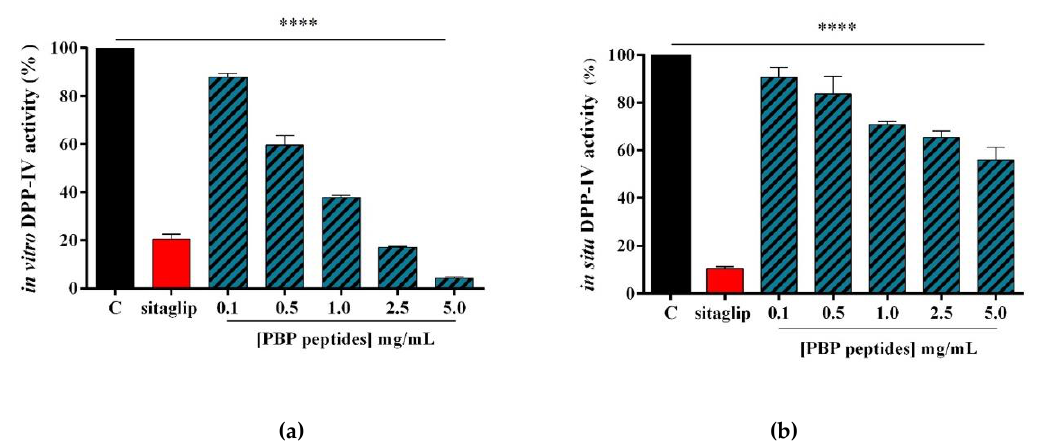
Figure 2. Evaluation of the inhibitory activity of the tryptic PBP hydrolysate on DPP-IV: ( a ) the in vitro inhibition of the activity of human recombinant DPP-IV; ( b ) the in situ inhibition of the DPP-IV activity expressed by non-differentiated Caco-2 cells, after 30 min of treatment. The data are represented as the means ± SD of six independent experiments, performed in triplicate. Statistical analysis was performed by one-way ANOVA, followed by Dunnett’s test (****) p< 0.0001.